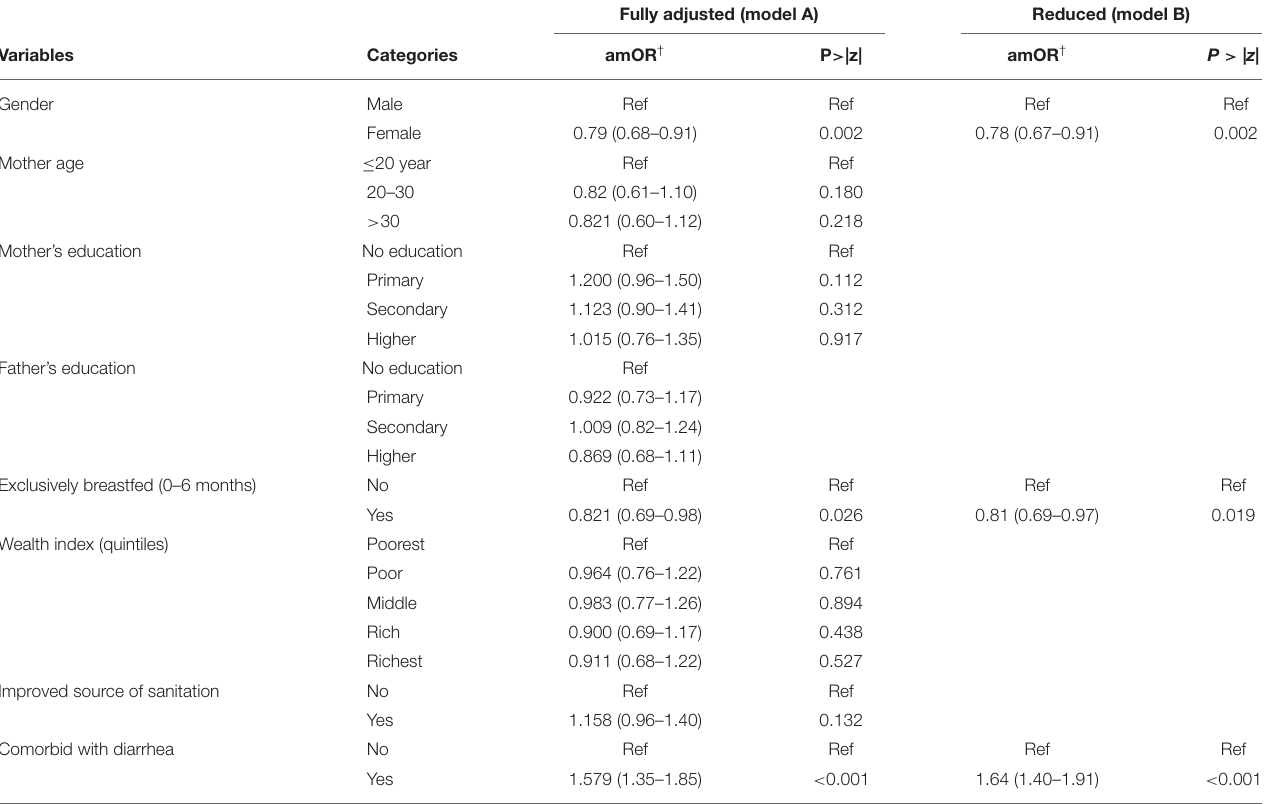
TABLE 4 | Multivariable analysis (fully adjusted and reduced) for risk factors associated with